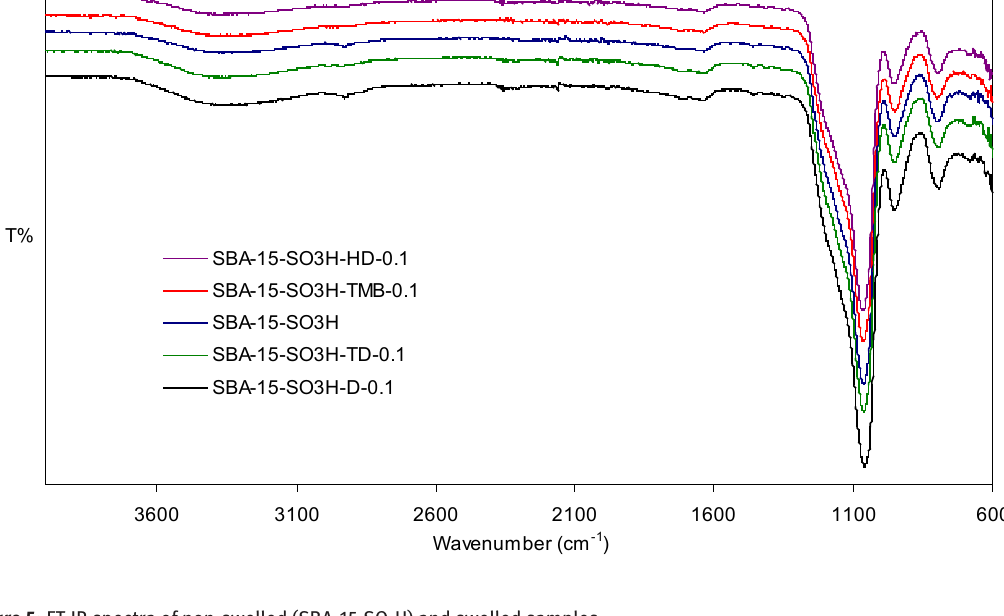
Figure 5: FT-IR spectra of non-swelled (SBA-15-SO